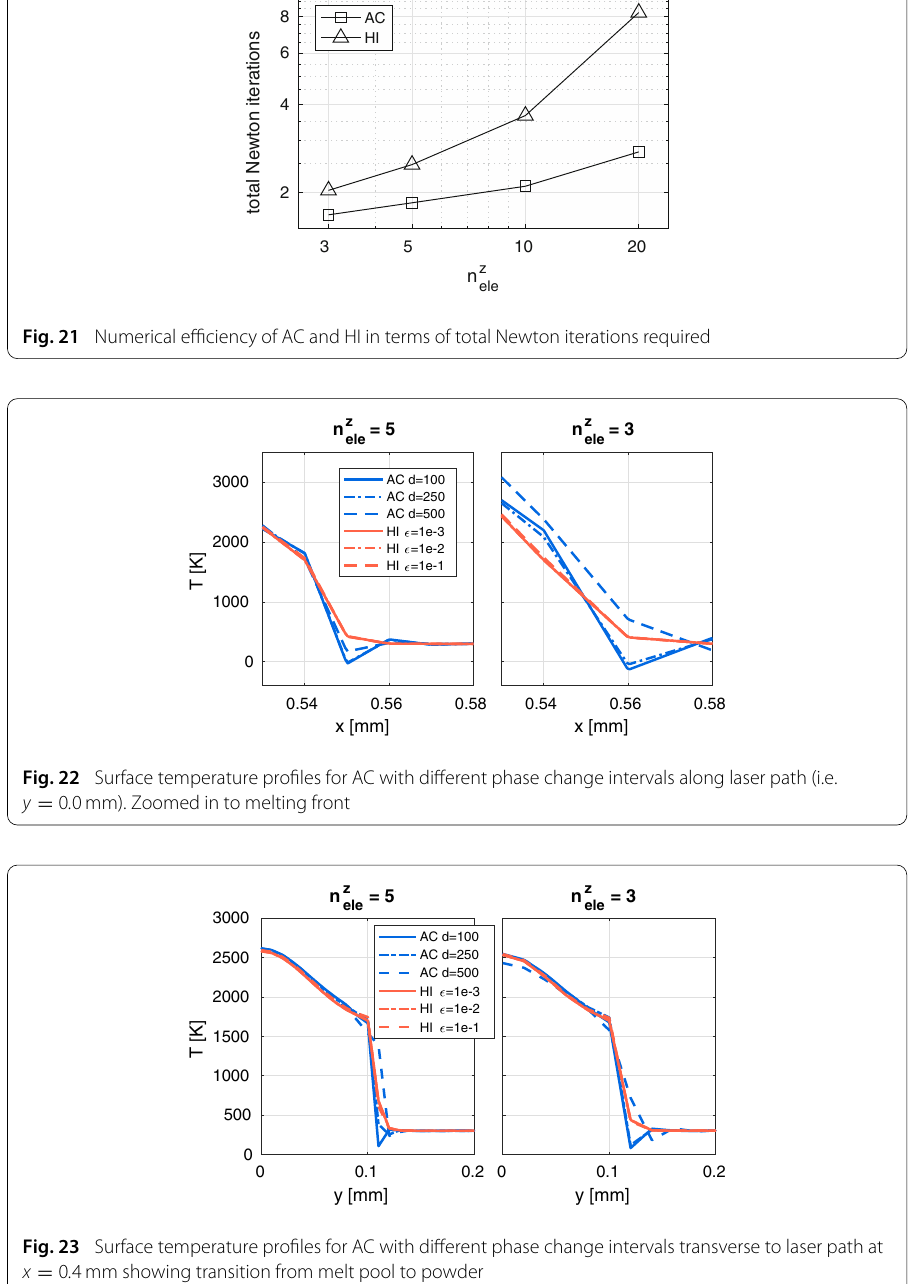
ε = 0 . 01 and ε = 0 . 1 are simulated. The resulting surface temperatures are plotted in tol tol Figs. 22, 23 and 24 in the regions that showed oscillations in the previous plots. While the increased phase change interval for the AC decreases the amplitude of these oscillations by a certain amount, the overall accuracy of the temperature profiles decreases as